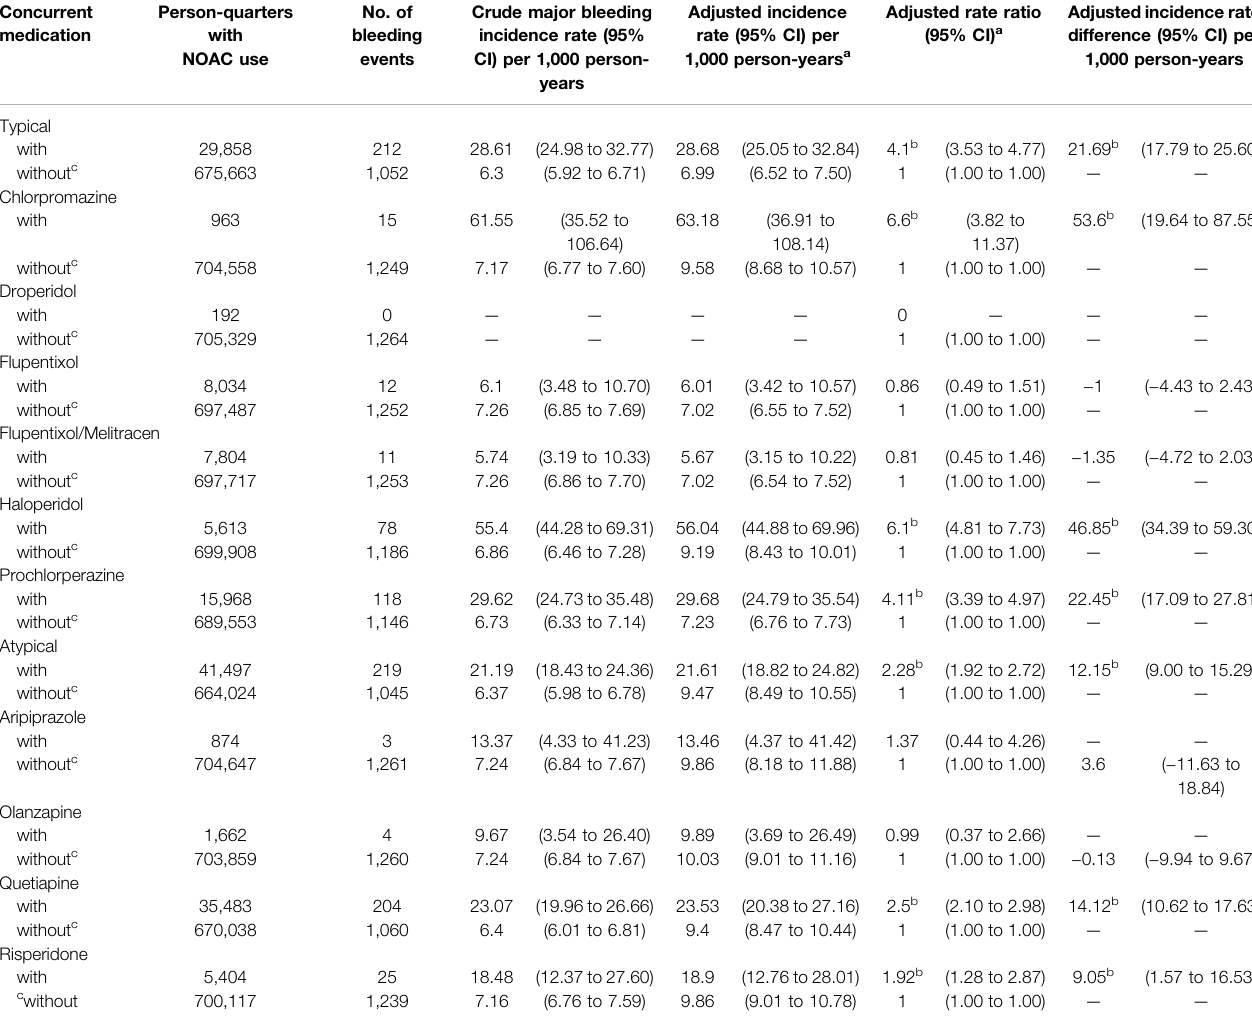
TABLE 4 | Risk of intracerebral hemorrhage among AF patients taking non-vitamin K antagonist oral anticoagulants with or without concurrent antipsychotics. Concurrent Person-quarters medication